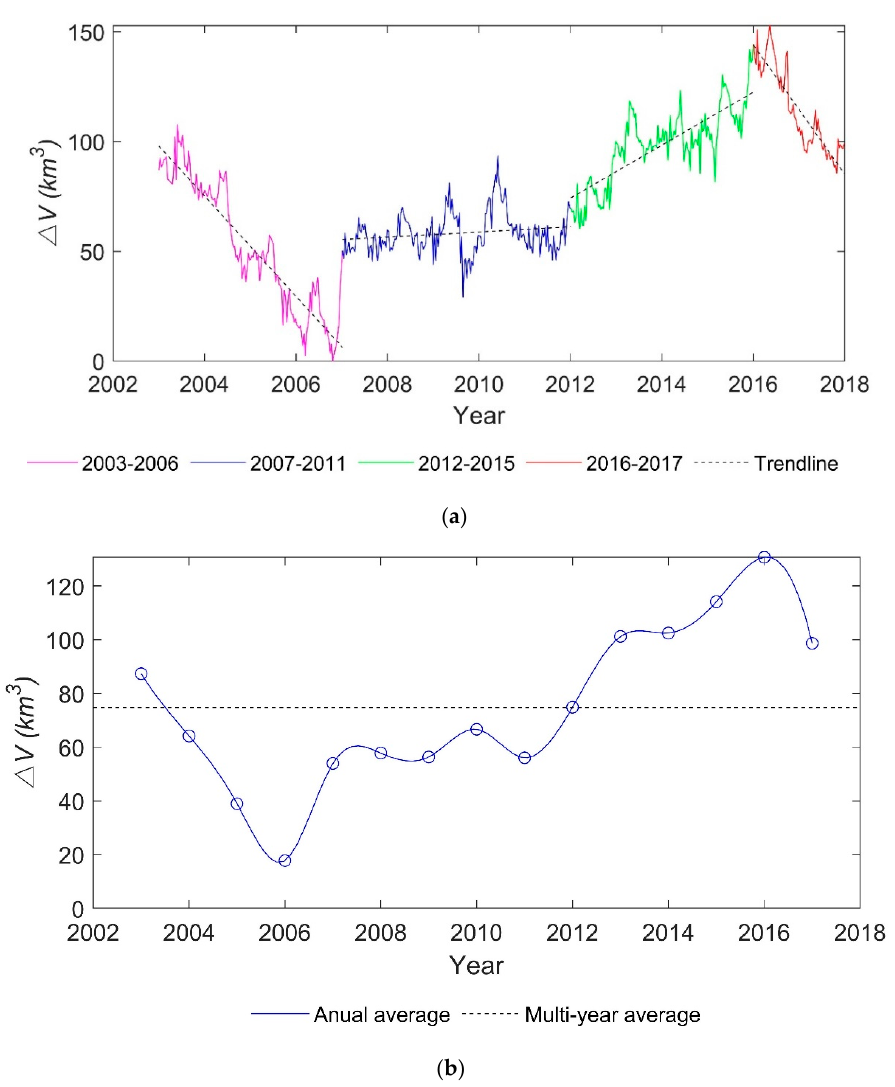
Figure 10. Annual period of long time series of Lake Victoria over the past 15 years: ( a ) water volume variations time series and ( b ) annual average.